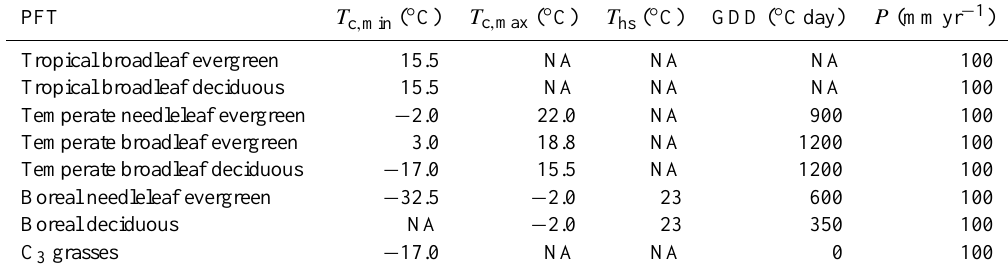
Table 1. Bioclimatic parameters for survival and establishment of plant functional type (PFT). Adapted from Table 1 in Bonan et al. (2003). PFT T c , min ( ◦ C) T c , max ( ◦ C) T hs ( ◦ C) GDD ( ◦ Cday) P (mmyr − 1 ) Tropical broadleaf evergreen 15.5 NA NA NA 100 Tropical broadleaf deciduous 15.5 NA NA NA 100 Temperate needleleaf evergreen − 2.0 22.0 NA 900 100 Temperate broadleaf evergreen 3.0 18.8 NA 1200 100 Temperate broadleaf deciduous − 17.0 15.5 NA 1200 100 Boreal needleleaf evergreen − 32.5 − 2.0 23 600 100 Boreal deciduous NA − 2.0 23 350 100 C 3 grasses − 17.0 NA NA 0